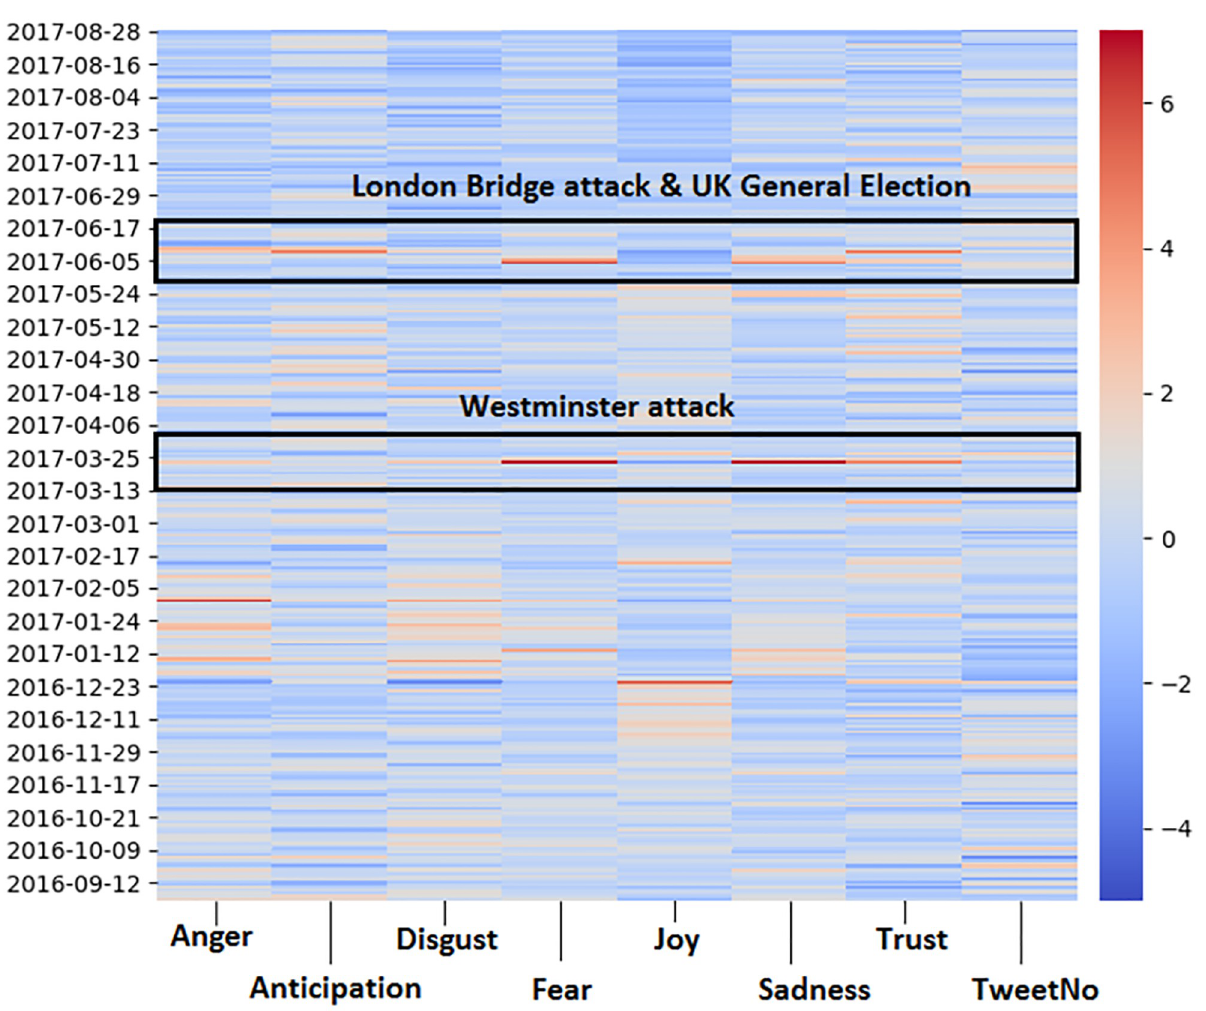
Fig 4. A time based heatmap of London (red = high levels of emotion, blue = low levels of